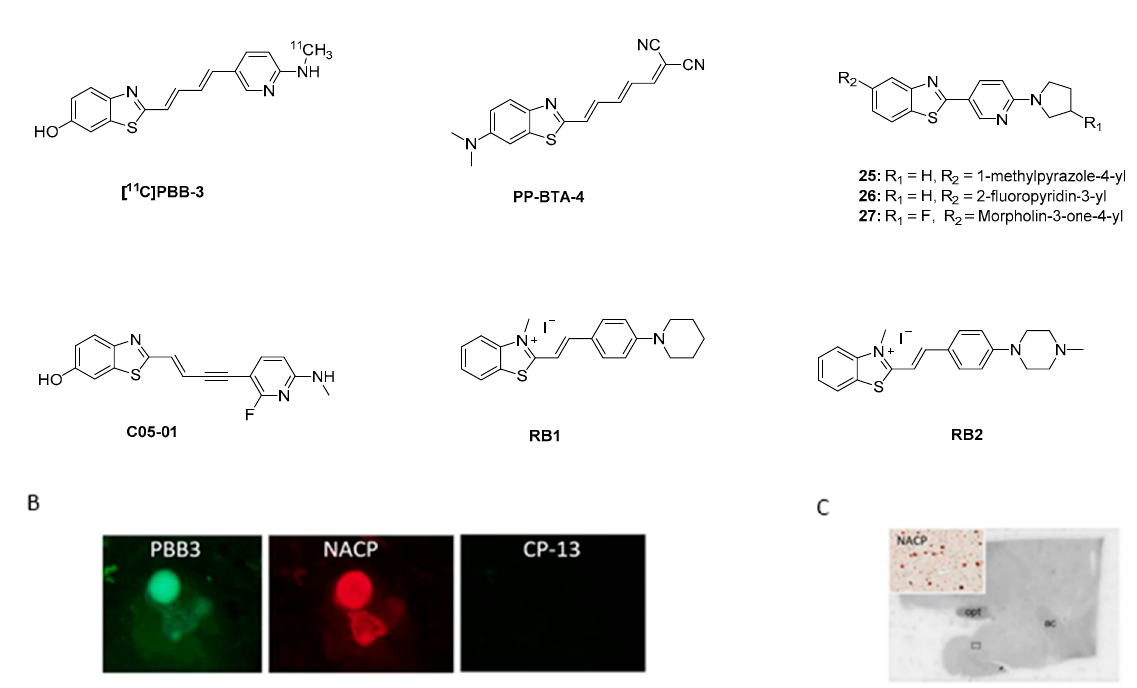
Figure 15. Chemical structures and examples of fluorescence and ARG. ( A ) Chemical structures of [ 11 C]PBB-3 , PP-BTA-4 , compounds 25, 26, 27 , and RB1 , RB2 . ( B ) PBB-3 fluorescence labeling and immunofluorescence double staining for α -syn (NACP) and phosphor-tau (CP13) in DLB from brainstem type LB (reprinted with permission from [111]. Copyright 2017 International Parkinson and Movement Disorder Society). ( C ) Autoradiographic labeling using [ 11 C]PBB-3 in amygdala of DLB patients (reprinted with permission from [111]. Copyright 2017 International Parkinson and Movement Disorder Society).